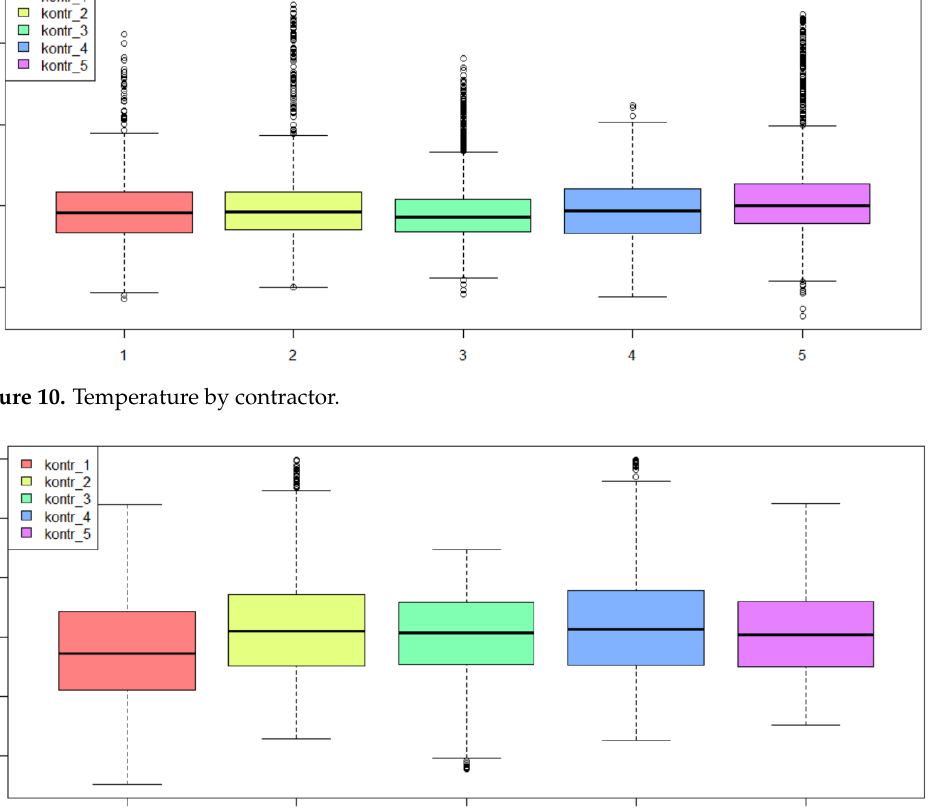
Figure 11. Humidity content by contractor.